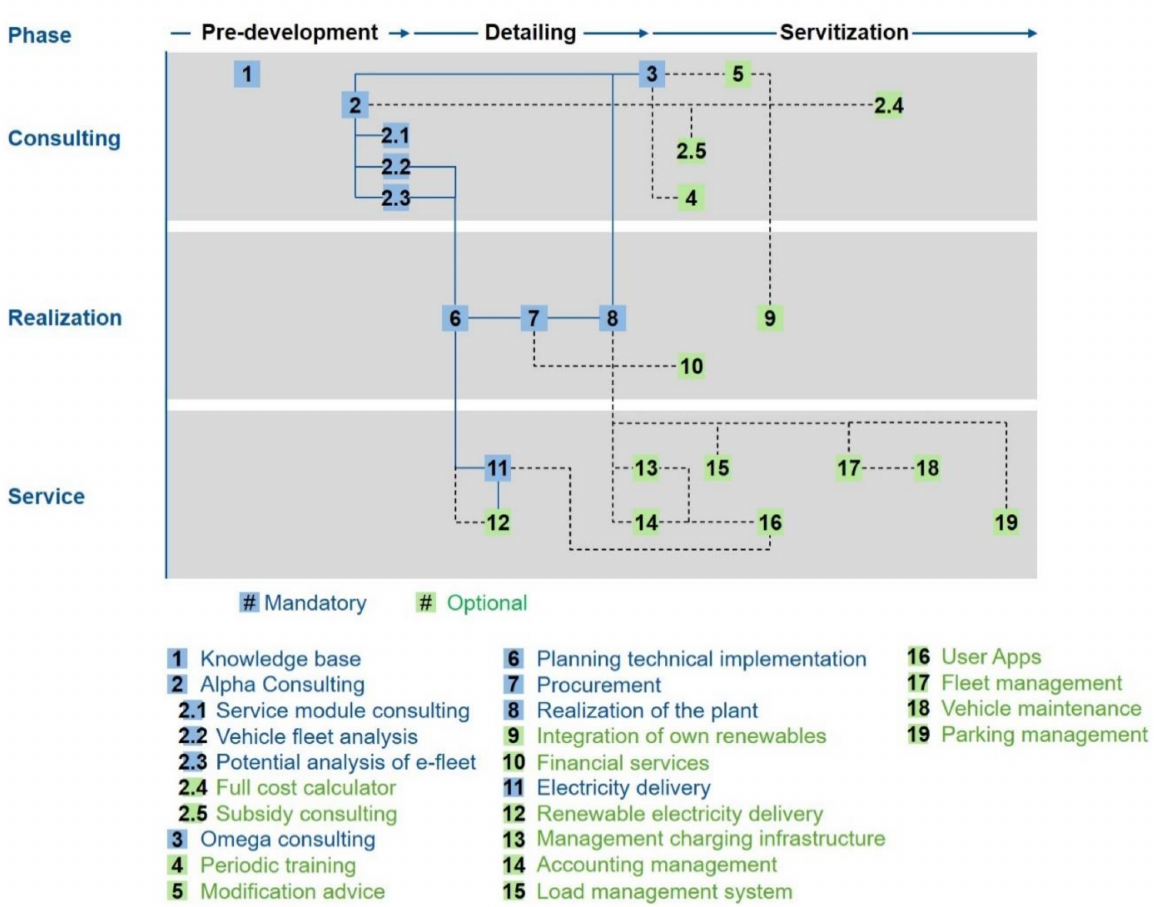
Figure 7. Implementation roadmap for the path